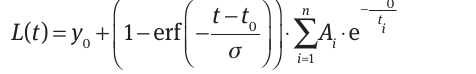
= 0.82 ns, t = 4.0 ns and 1 2